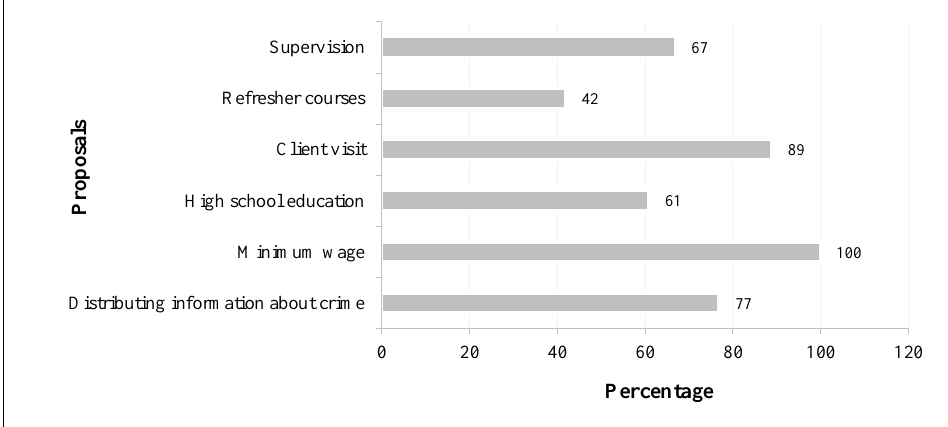
Figure 2. Proposals to commercial security firms.